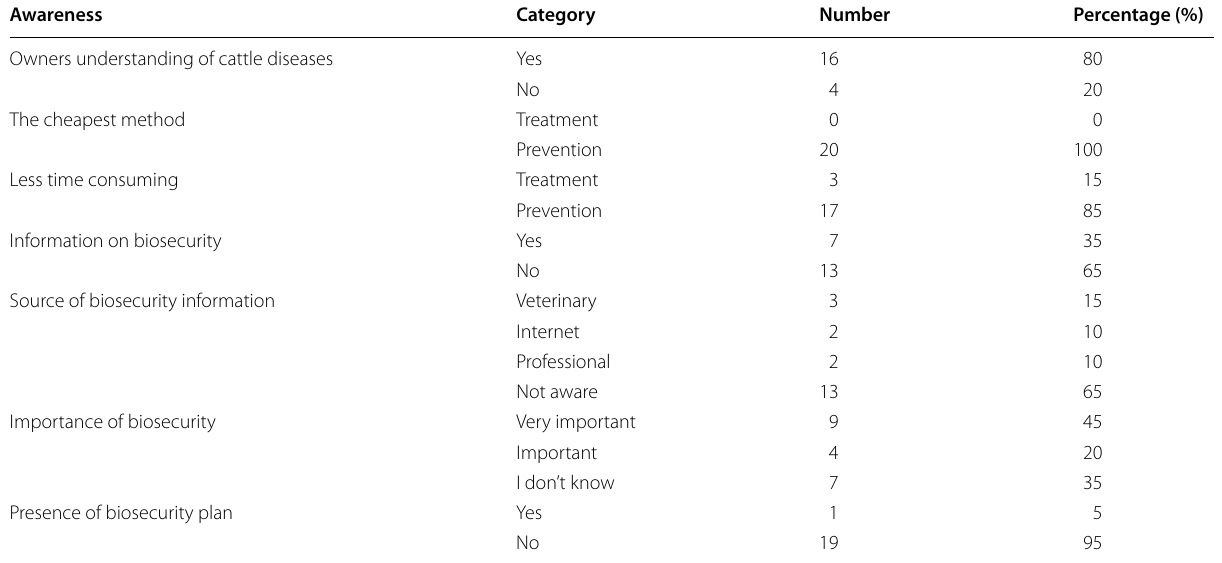
Table 2 The percentage of cattle owners aware of cattle disease control and biosecurity